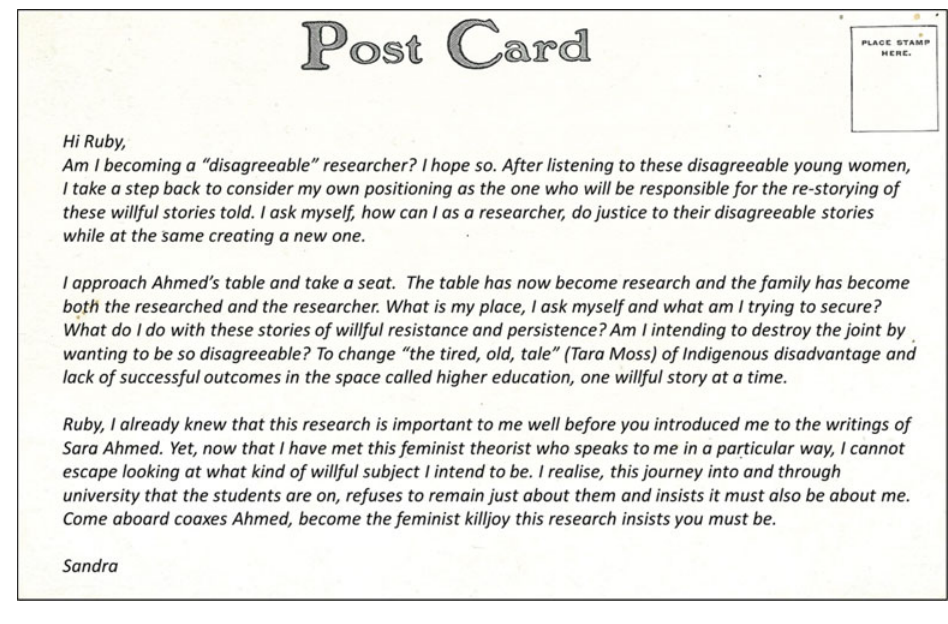
(Colour online) Postcard from a disagreeable